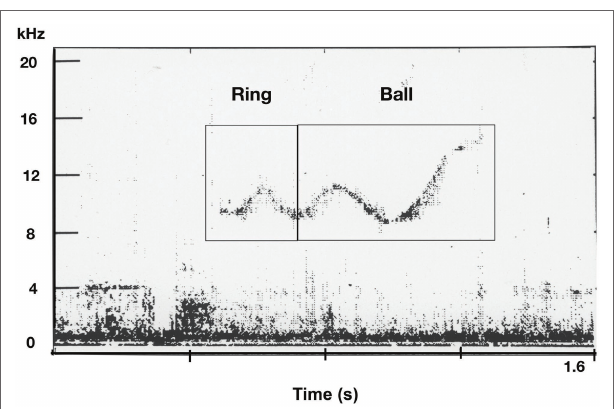
FIGURE 7 | Spectrogram of an apparent combination whistle spontaneously produced by a bottlenose dolphin. The initial element resembles the computer-generated ring whistle and the end of the whistle resembles the computer-generated ball whistle. (from Reiss and McCowan,